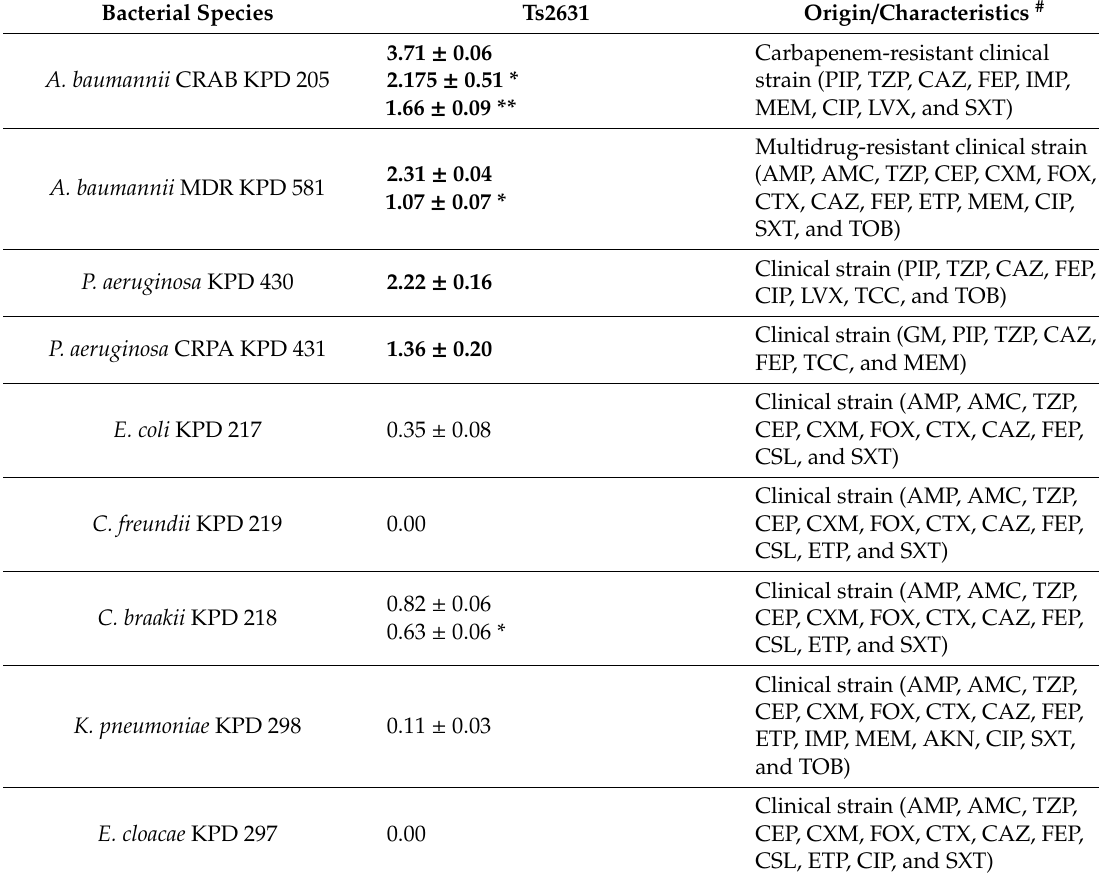
Table 1. Bactericidal activity of Ts2631 against several Gram-negative bacterial pathogens. The significant log reduction units observed ( ≥ 1 log kill) are marked in